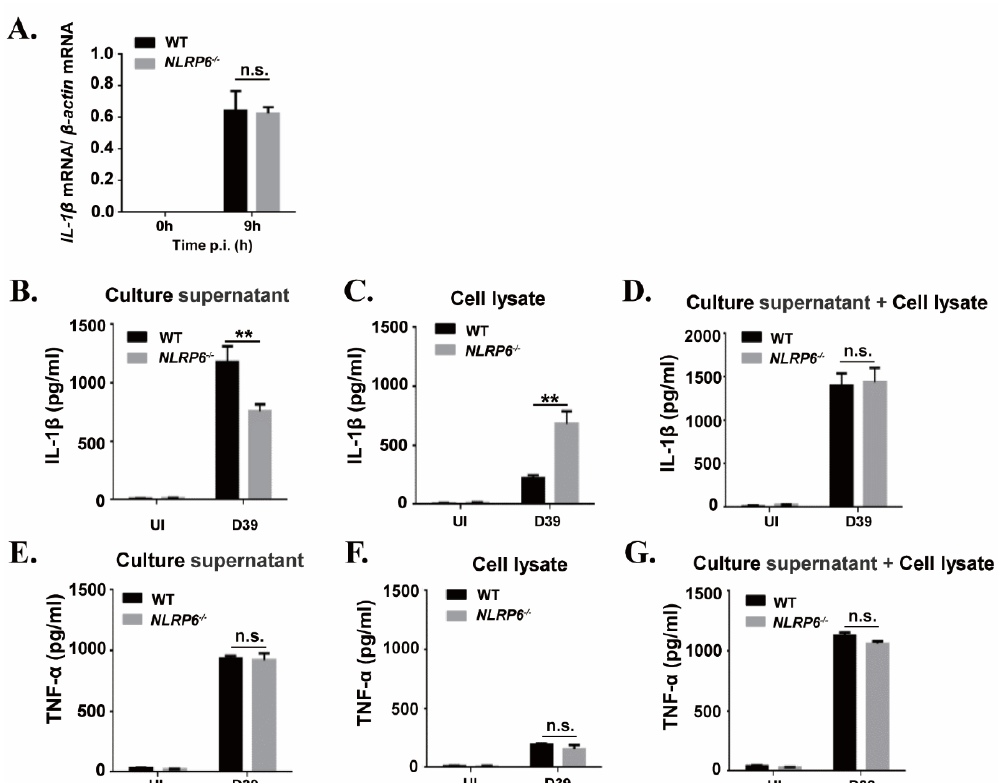
Figure 2. NLRP6 mediates maturation and secretion of IL-1 β but does not regulate the induction of IL-1 β mRNA in S. pneumoniae -infected macrophages. Macrophages were infected with the S. pneumoniae at an MOI of 1. ( A ) Total cellular RNA was extracted 9 h after infection, and the level of IL-1 β mRNA expression was analyzed by real-time RT-PCR. The levels of IL-1 β ( B – D ) and TNF- α ( E – G ) in the culture supernatants and cell lysates were determined by ELISA at 24 h post infection. All of the experiments independently performed three times. Statistical significance was determined by Student’s t -test (** p < 0.01).